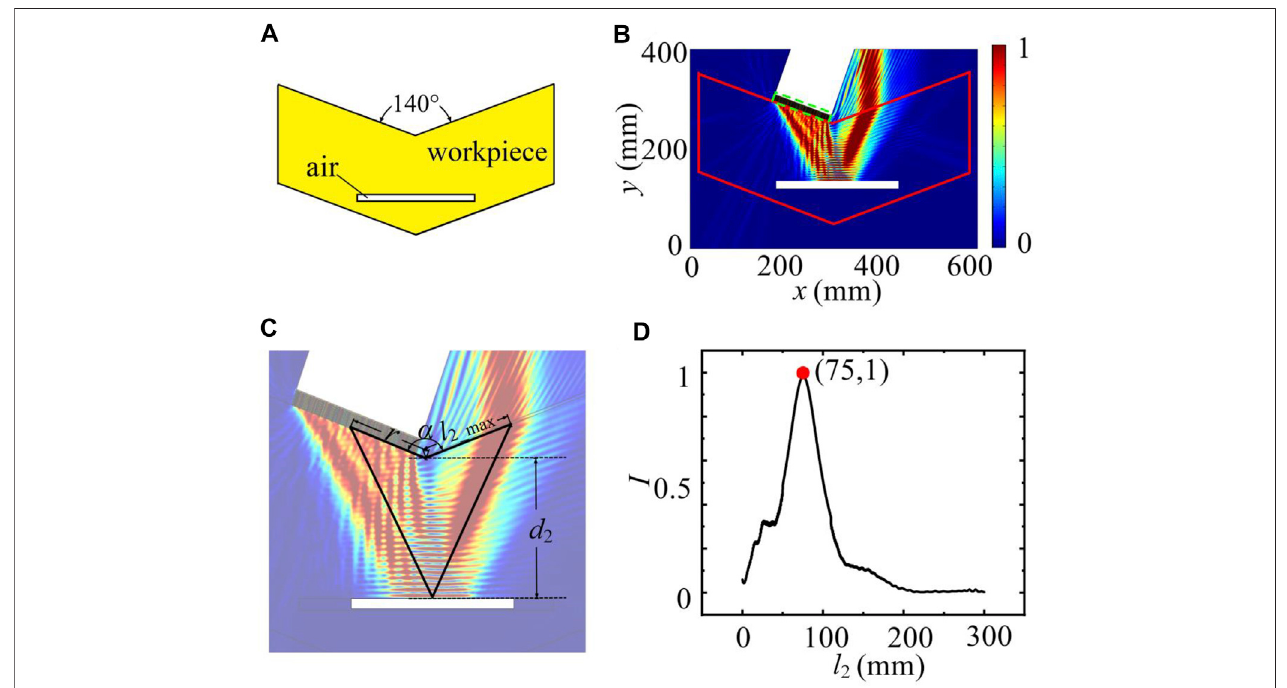
FIGURE 4 | The defect detection inside the V-shaped workpiece with the planar ultrasound metasurface. (A) The schematic of the V-shaped workpiece made of plexiglasswithastripofairdefectinsideit. (B) UltrasoundintensitydistributioninthedefectdetectioninsidetheV-shapedworkpiece(indicatedbytheredsolidbox)with the planer metasurface (green dashed box). (C) Trajectories of the directionalemitted and re fl ected ultrasound beams. (D) Distributions ofultrasoundintensity along the top-right surface of the workpiece, as function of the distance l 2 from the corner of the workpiece.